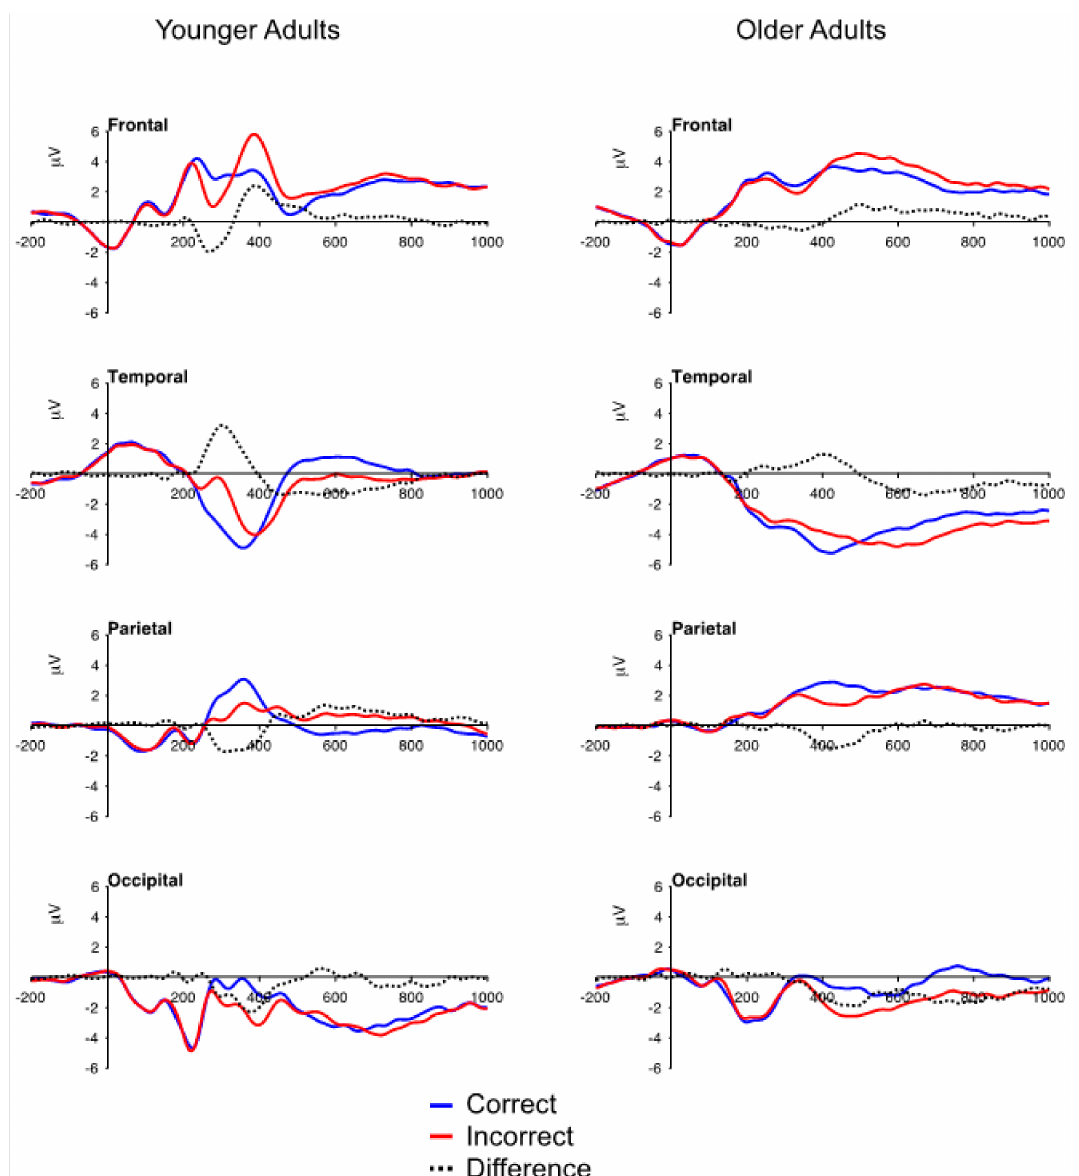
Figure 1. Grand-averaged ERP waveforms for correct and incorrect feedback trials and the incorrect minus correct di ff erence waves for younger and older adults averaged across four medial frontal, temporal, parietal, and occipital electrodes. The tall bar marks onset of the feedback stimulus and positive is plotted